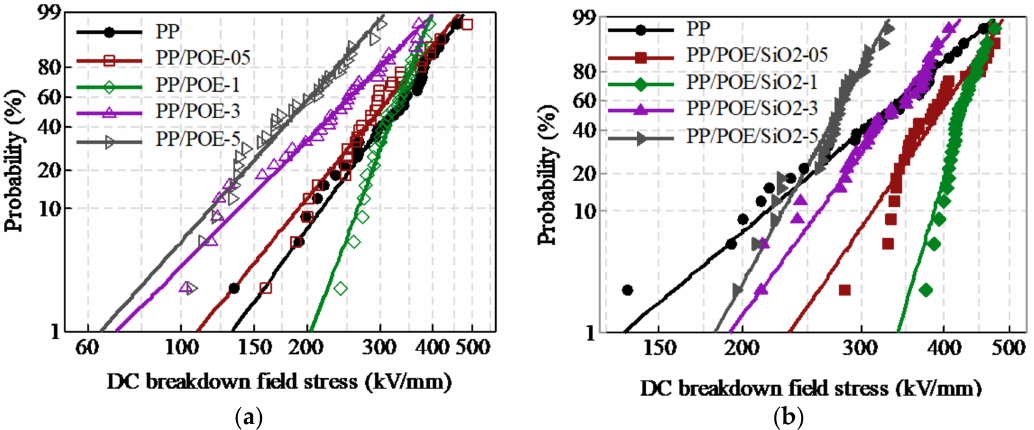
Figure 3. Weibull distribution of breakdown strength. ( a ) was the electric strength distribution of PP with POE blending, ( b ) was the electric strength distribution of PP with POE and nano-SiO 2